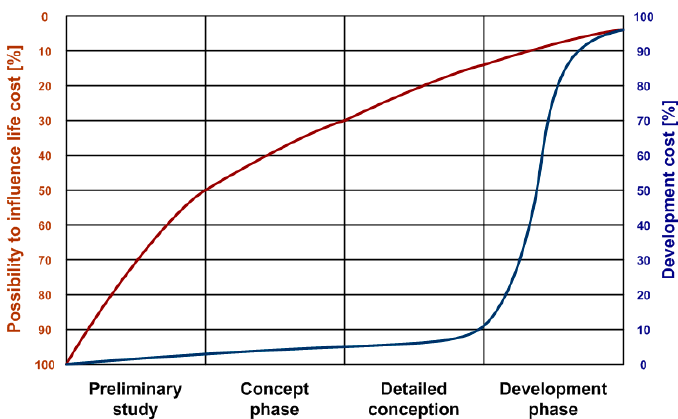
Figure 3. Leverage of development expenditures inspired from Reference [9].